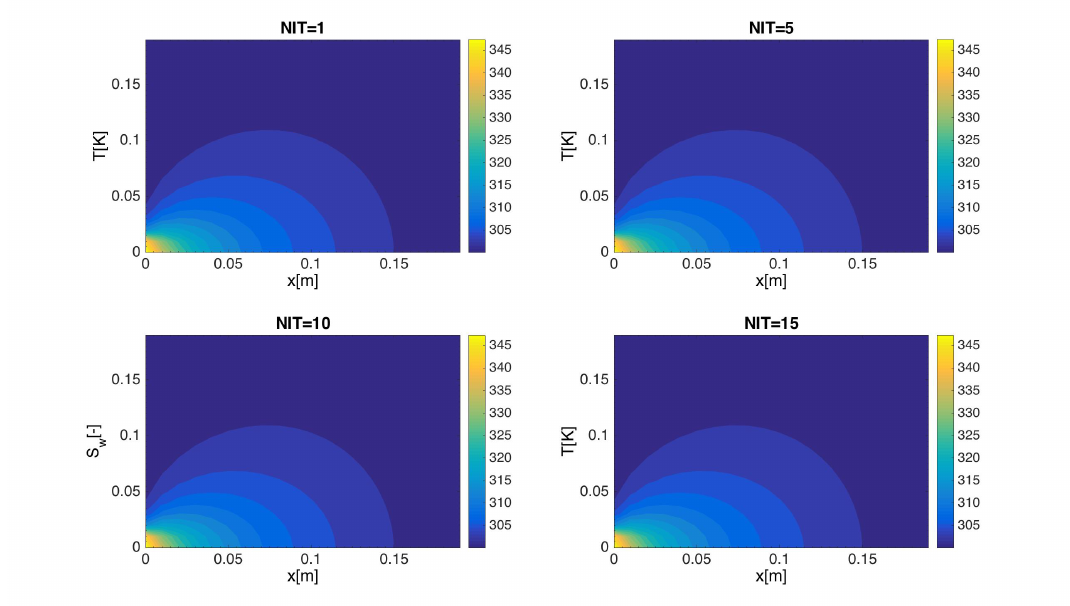
Figure 8. Distribution of saturation on heterogeneous permeability for different number of